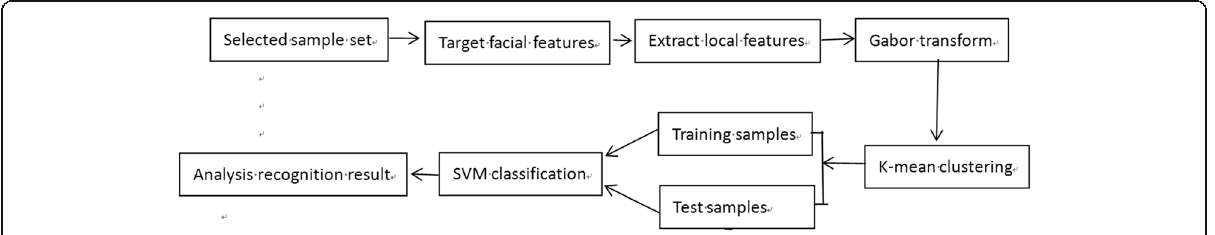
Fig. 1 Face recognition framework based on